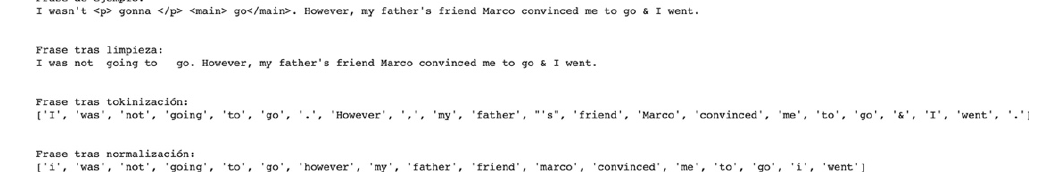
Figure 11. Text preprocessing results.